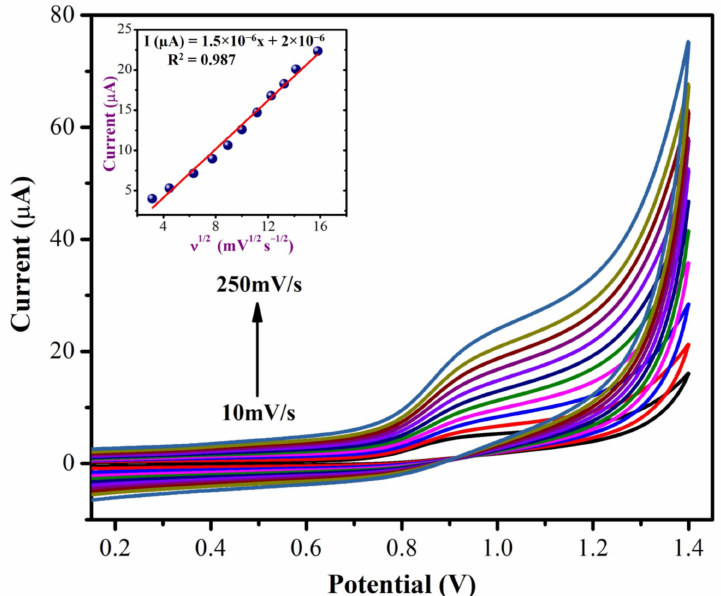
Figure 10. Different scan rate studies were carried out using a MXene/PHC composite modified GCE with 0.5 mM NIC. Inset: A linear curve was made between the square root of scan rate (mV s − 1 ) vs. oxidation current ( µ